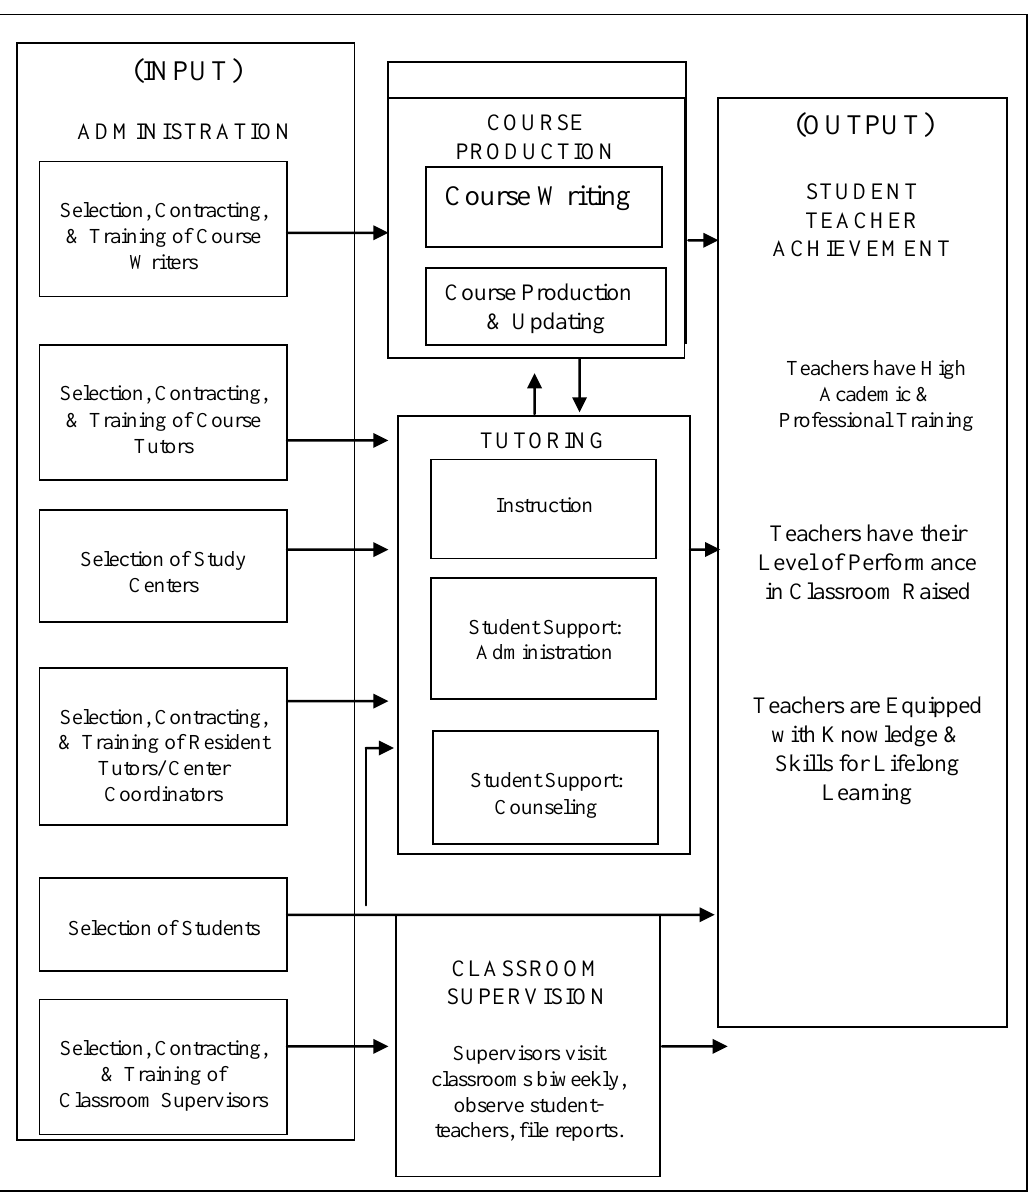
Figure 2 . Program network showing the various components and the interconnections between